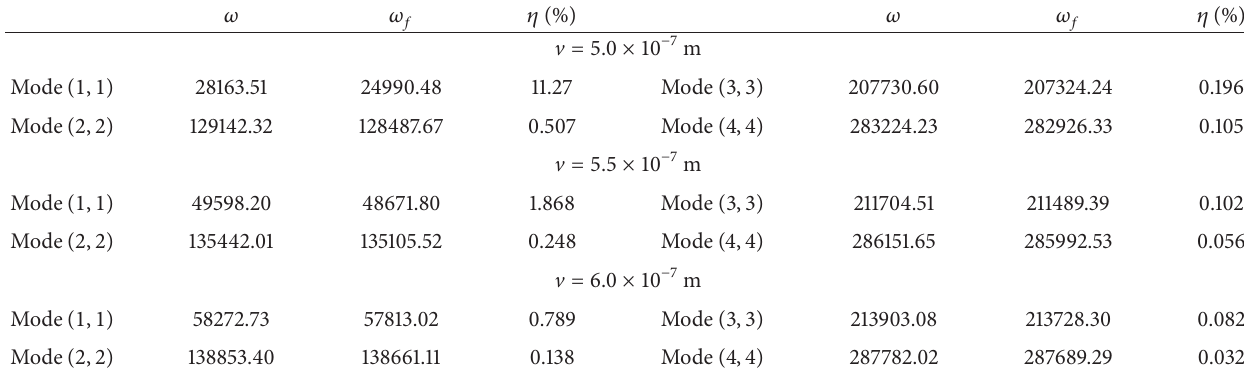
Table 2: Natural frequency of the micro pressure sensor for various clearances (rad/s).